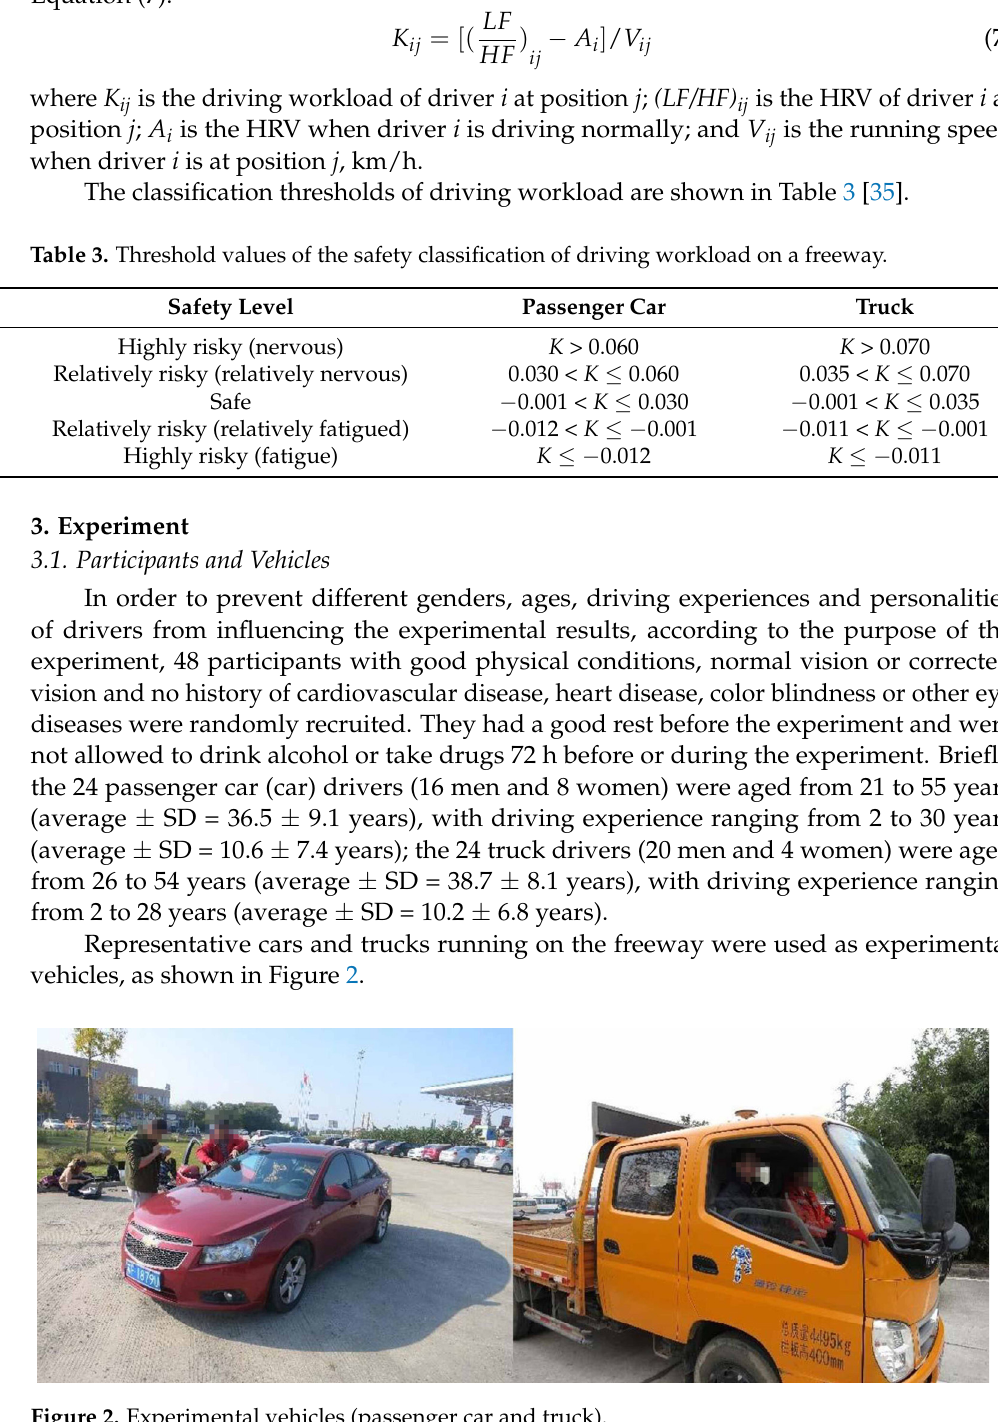
Figure 2. Experimental vehicles (passenger car and